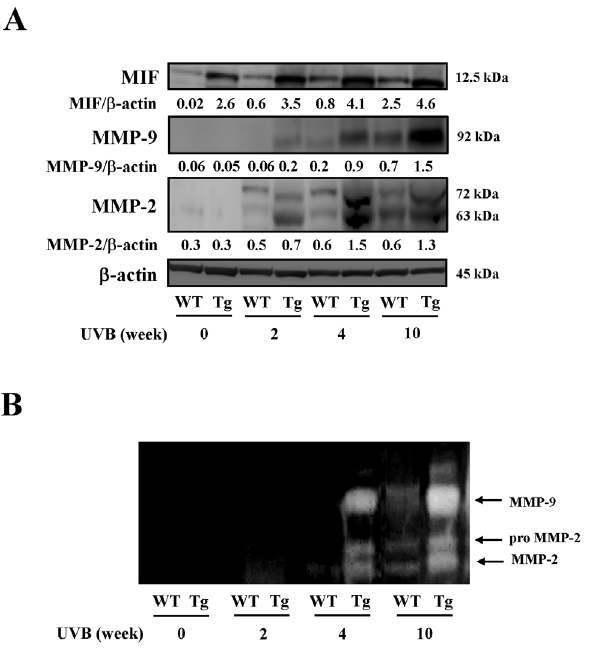
Figure 2. Enhanced production of MIF, MMP-9 and MMP-2 in the MIF Tg mouse skin following chronic UVB exposure. (A) Western blot analysis of MIF, MMP-2 and MMP-9 was conducted to evaluate the effects of UVB (300 mJ/cm 2 6 3/week) on the expressions of these compounds in comparison with those observed in WT mice. The band of b -actin was used to normalize each expression level. Each band shows a representative result of the Western blotting analyses, which were repeated five times. A densitometric analysis was also performed to evaluate the intensity of each band. (B) Zymography, using the total skin specimens of each indicative sample, is shown. (These experiments were repeated two times with similar results).